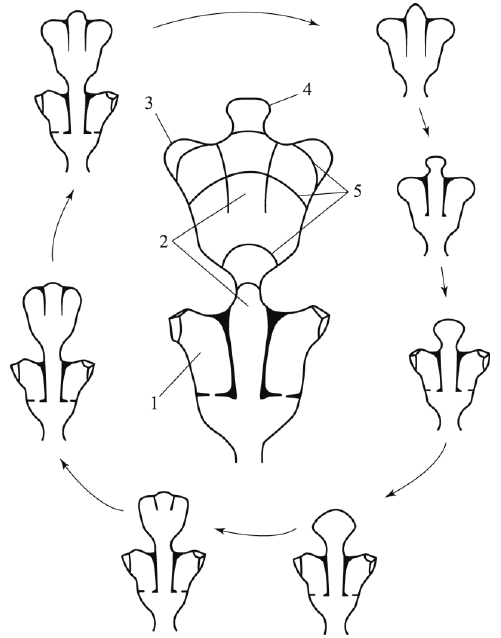
Figure 2. The morphogenetic cycle of the formation of the Dynamena pumila (L.) shoot module, presented in two equivalent variants: in the central part of the figure, the stages of formation are marked by isolines; in the periphery of the figure, the same stages are shown in a clockwise sequence. Legend: 1—hydrotheca; 2—the central part of the shoot, in which the cenosarc is located; 3—the rudiment (bud) of a hydrant; 4—the tip of the shoot growth at an early stage of formation; 5—isolines marking the growth stages of the shoot apex, and the formation of a module with two oppositely located hydrants in the hydrothecae; the dotted arrow symbolizes the transition to the initial stage of module formation, that is, the closure of the morphogenetic